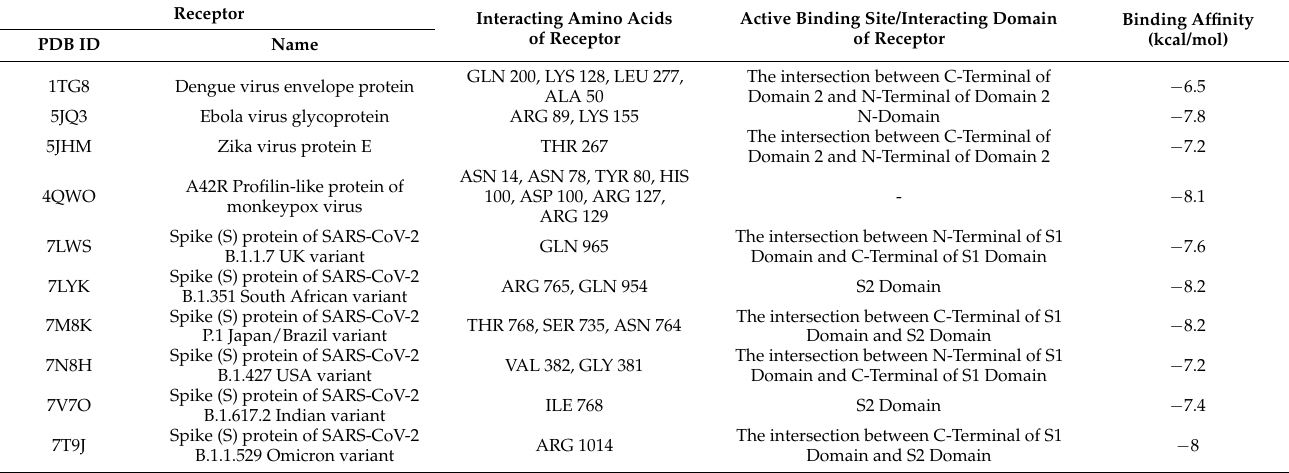
Table 12. Molecular docking analysis of hapalindole H